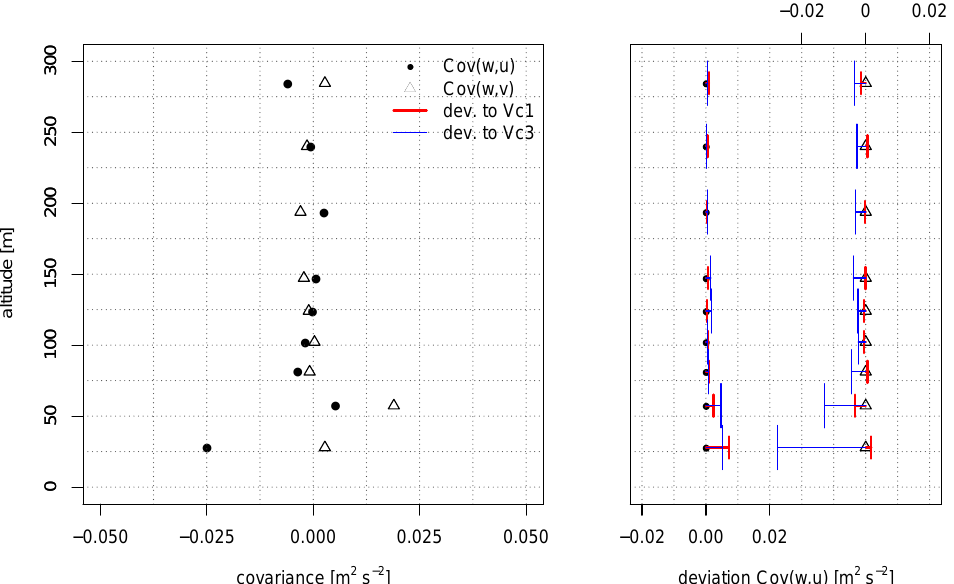
Figure 8. Height profiles of the ISOBAR flight with the altitude AMSL of the covariances Cov( w , u ) and Cov( w , v ), calculated with the calibration polynomial at v c 2 ( left ). Deviations ( right ), when applying the calibration polynomials at v c 1 and v c 3 .